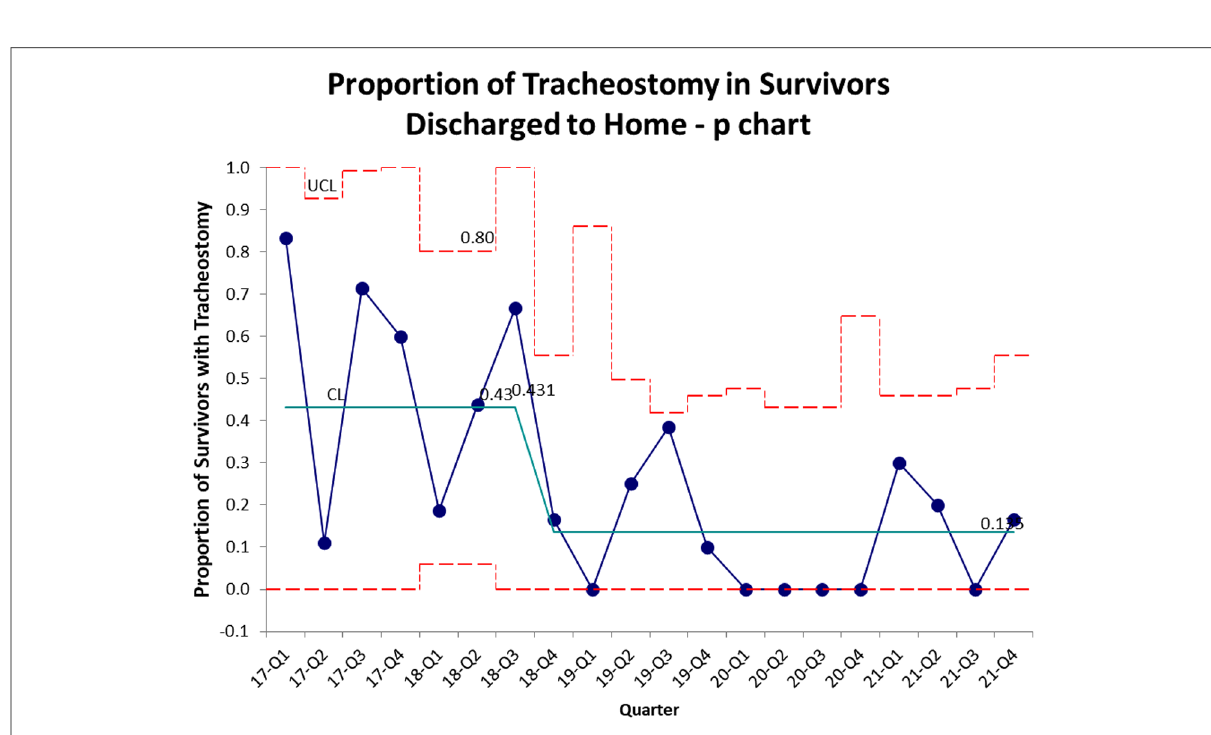
FIGURE 2 Proportion of survivors requiring tracheostomy.